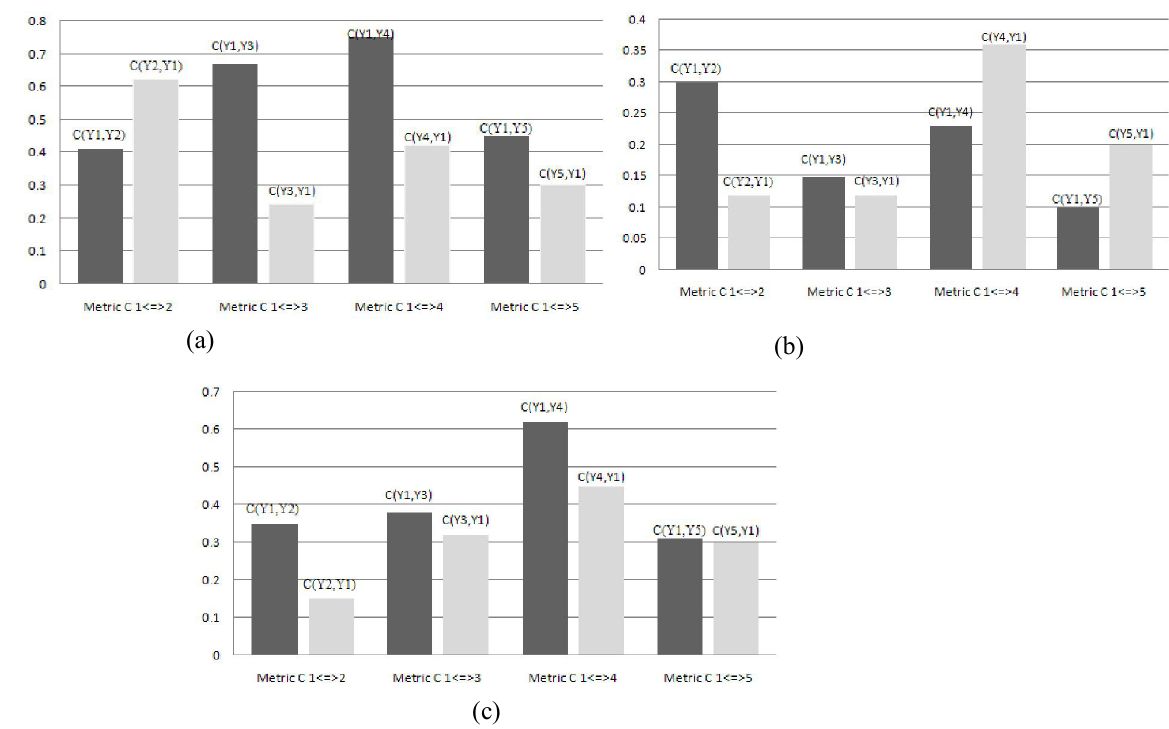
Fig. 5. Final result for problems of Kacem et al.